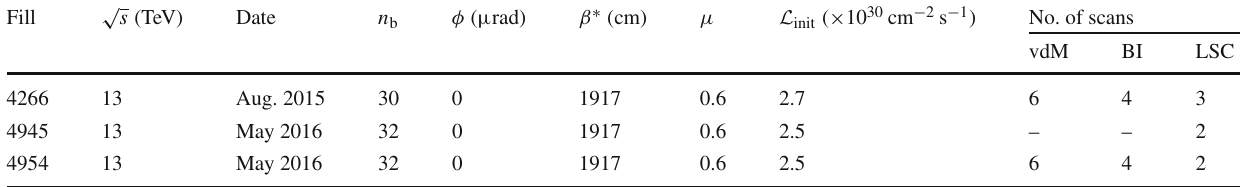
Fig. 3 Relative change in the positions of beams 1 and 2 measured by the DOROS BPMs during fill 4954 in the horizontal ( x ) or vertical ( y ) directions, as a function of the time elapsed from the beginning of the program. The gray vertical lines delineate vdM, BI, or LSC scans Table 1 Summary of the LHC conditions at IP 5 for the scan sessions luminosity. The columns corresponding to “No. of scans” indicate the in pp collisions in 2015 and 2016. The column labeled μ is the average total number of vdM, BI, and LSC scans that were performed in either pileupcorrespondingto L init ,thelatterdenotingtheinitialinstantaneous transverse coordinate, counting only scans used for